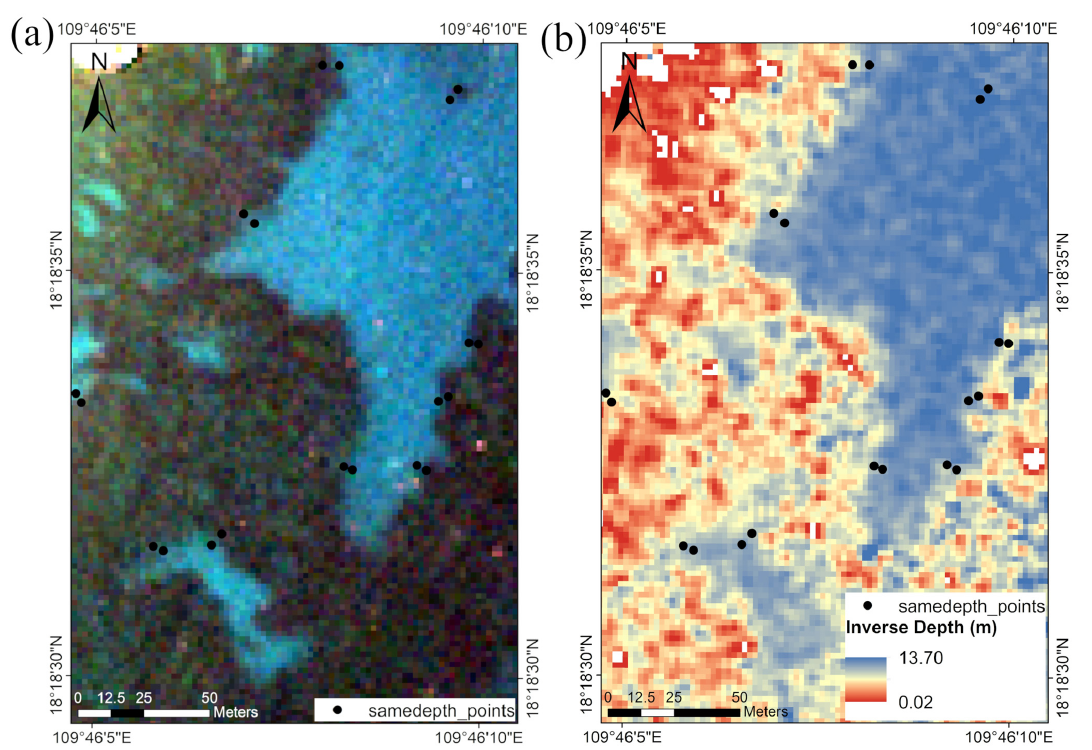
Figure 12. Comparison of remote sensing images and bathymetry inversion results in the southeastern waters of Wuzhizhou Island. ( a ) Image in the southeast; ( b ) inverse water depth. The results of the adjacent points can overcome the influence of strong reflection sub- strates on the results of bathymetric inversion. The relative error method is used to con- firm the correctness of the results (Figure 13b).